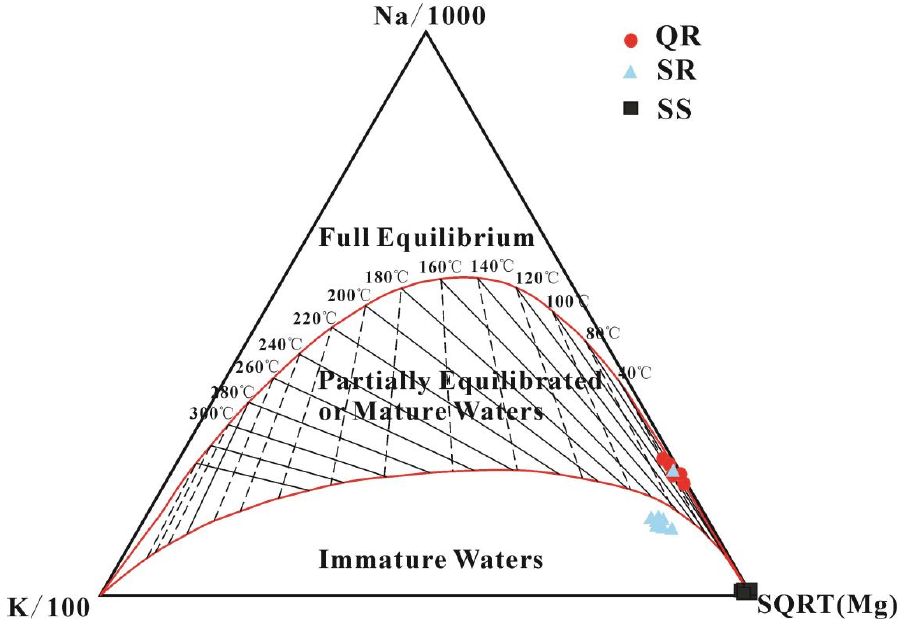
Figure 4. Composition of the geothermal fluids shown on a Na–K–Mg ternary diagram.